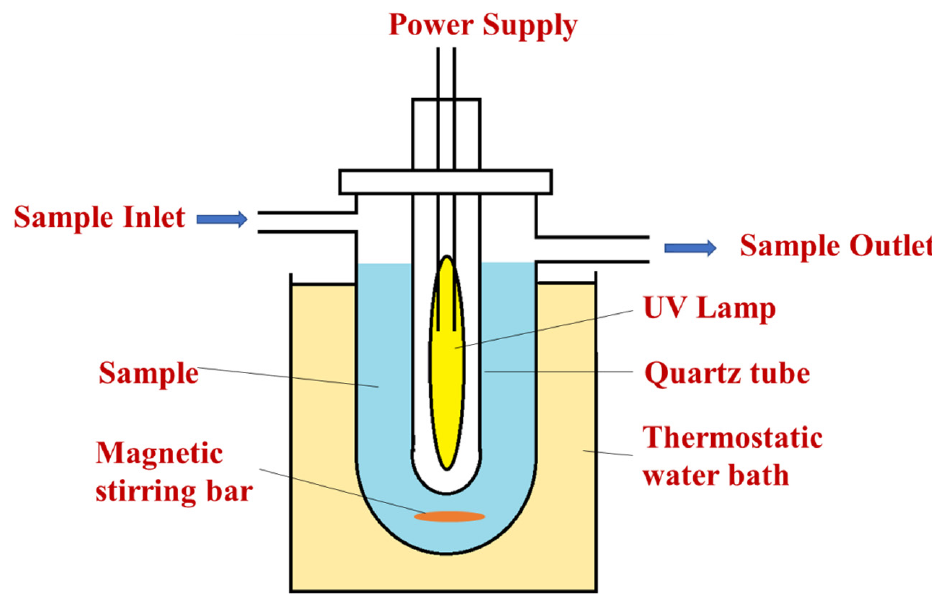
Figure 10. Design of the photoreactor.